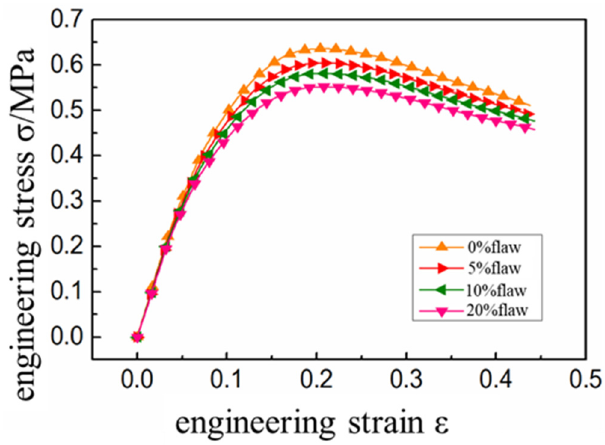
Figure 9. Uniaxial tensile results of HTPB propellant with initial interface defects.